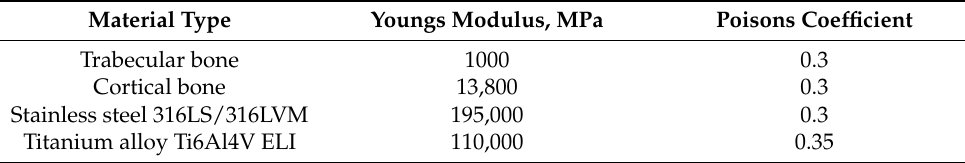
Table 1. Bone tissues, POD, and mini-implants mechanical